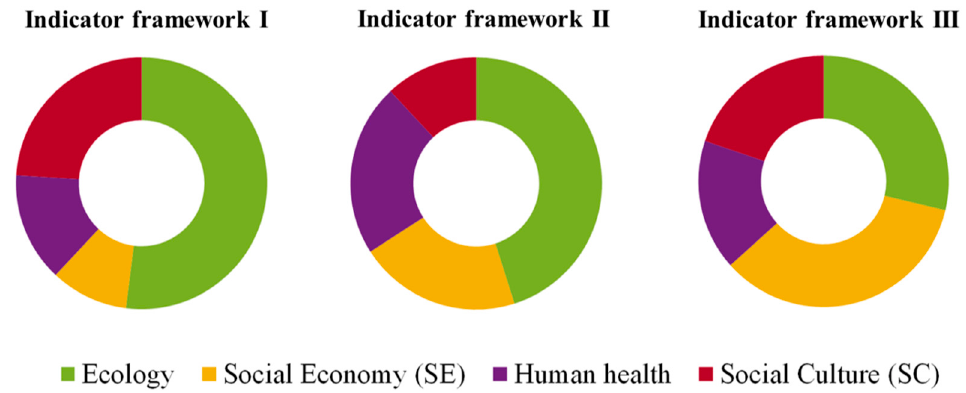
Figure 4. Indicator framework I to III in terms of ecological, socio-cultural, socio-economic, and human health dimensions.